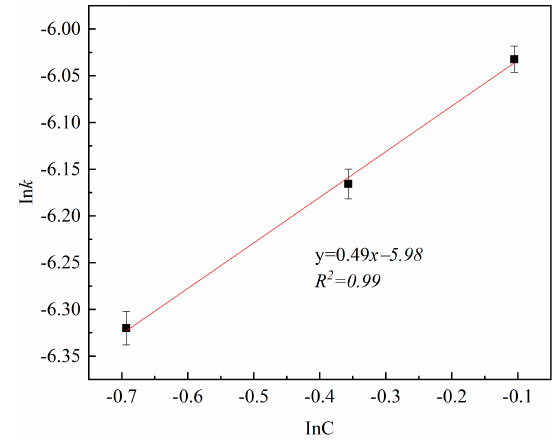
Figure 5. Relationship between Ink and 1/ T . Figure 8. Plot of Ink and InC Na3PO4